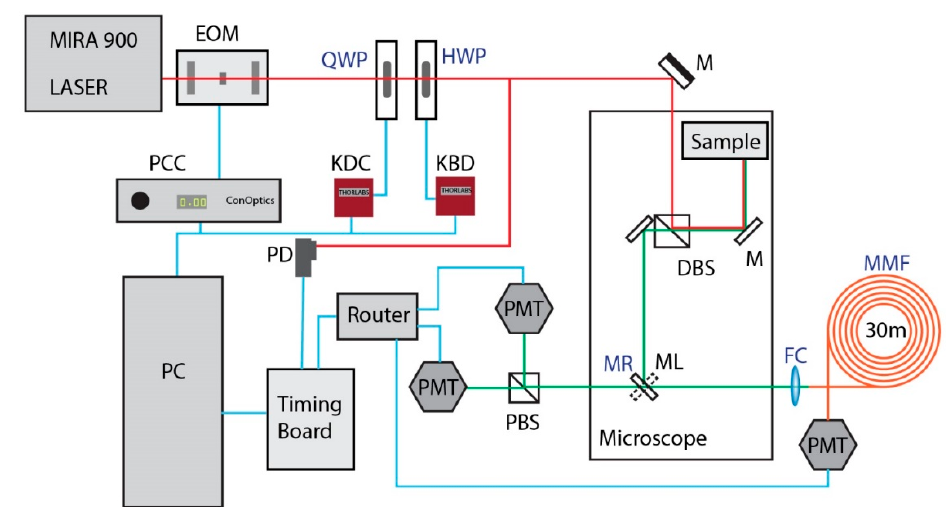
Figure 2. Optical schematic for the fiber-HDIM setup. The laser (Coherent MIRA) passes through an Electro-optic Modulator (EOM) and a polarization control unit that consists of a quarter waveplate (QWP) and a half wave plate (HWP). The light is guided using a mirror (M) into the microscope, and a dichroic beamsplitter is used to split the fluorescence from the excitation light. The emission travels to the port selection mirror right/left (MR-ML). The MR port sends the light to a fiber coupler (FC) and a multimode fiber (MMF) to the Photomultiplier tube (PMT). The ML port directs the light to a polarizing beam splitter (PBS) and two PMTs collecting photons at orthogonal polarization states. The ML port is only used for validation. The PMT signals from all ports and channeled to the router and read by a timing board. The timing board also compares the laser excitation timing from a photodiode (PD) and calculates arrival times of photon. The ML port is an anisotropic validation system, and the MR port is the fiber-HDIM system. The timing information is fed to the PC (computer), which can control the spatial position of the laser and map an image using Micromanager (MM). The EOM is controlled using a Pockels cell Controller (PCC), and the waveplates are motorized using Thorlabs Kinesis motor drivers KDC and KBD based on whether a D.C. or Brushless Motor is used for rotation.